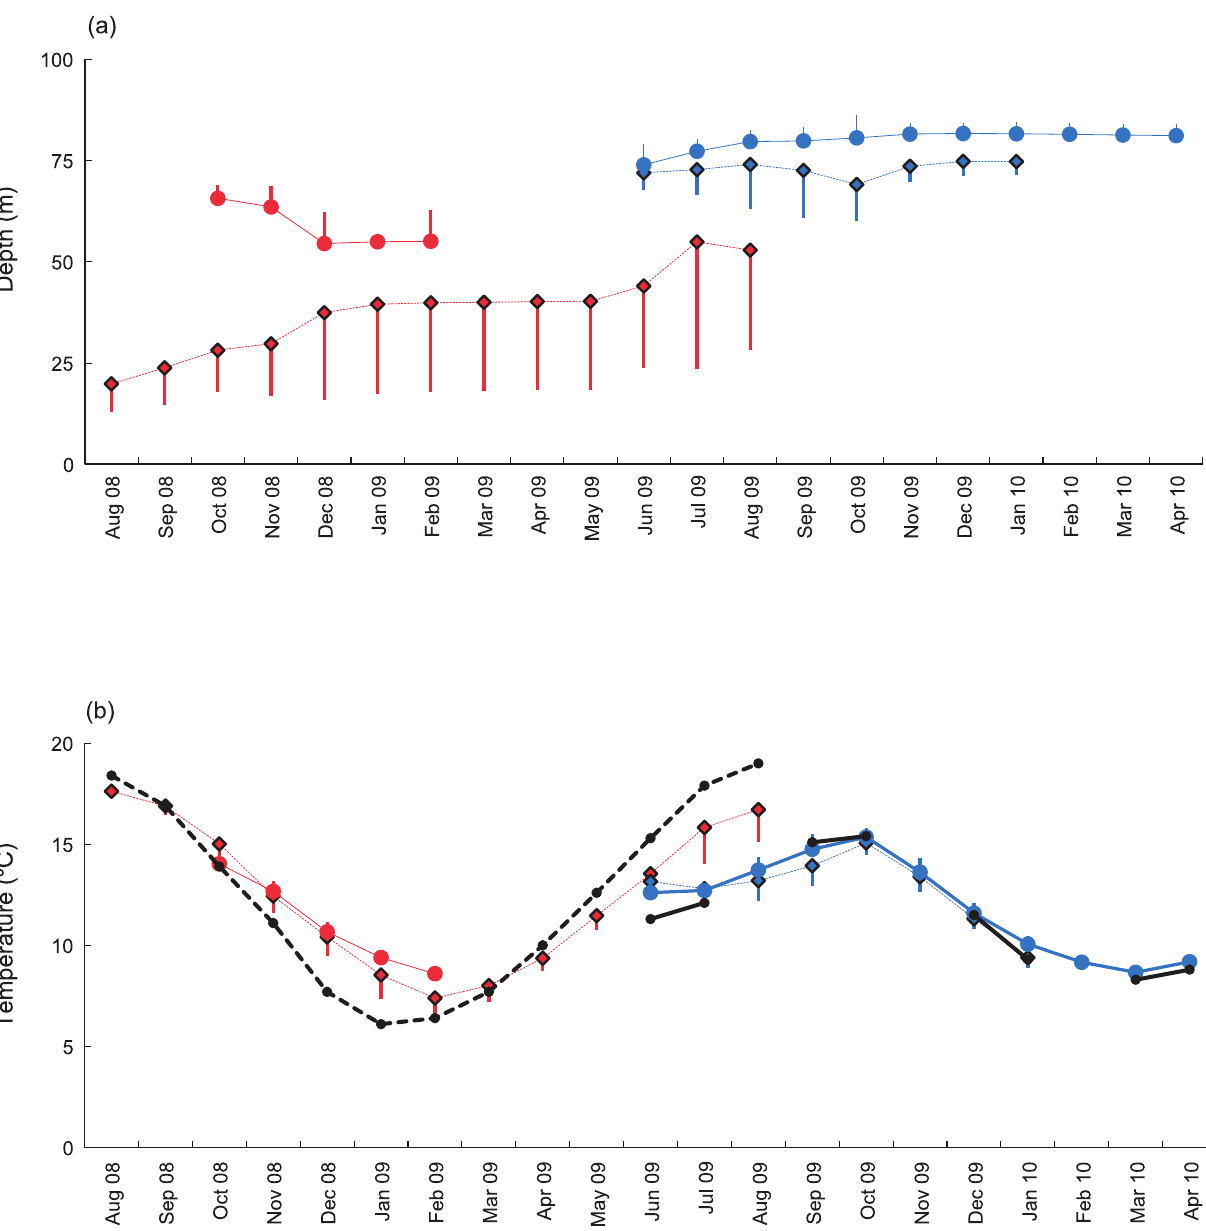
Figure 3. Average depth and temperature experience of edible crab. Average monthly (a) depths and (b) temperatures ( 6 s.e) experienced by DST-tagged crabs released in the English Channel and Celtic Sea. Black lines (b only) indicate average monthly temperatures in the eastern Channel (broken line) and approximately monthly CTD measurements in the western Channel (intermittent solid line). Key: red diamonds, dashed line, Eastern Channel; red circles, solid line, Celtic Sea; blue circles, solid line, Western Channel Coastal; blue diamonds, dashed line, Western Channel Offshore.